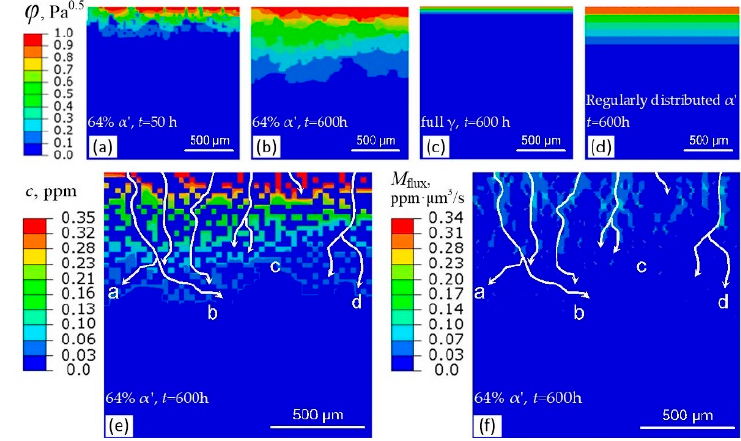
Figure 16. Contour results obtained by ABAQUS. ( a – d ) Normalized hydrogen concentration, φ ; ( e ) hydrogen concentration, c; ( f ) magnitude of the concentration flux vector of hydrogen, Mflux. The white lines with arrows in ( e , f ) represent the hydrogen diffusion path. The locations, where α′ squares connect with each other to form a path, i.e., ( a – d ), show the role of α′ as diffusion “highways”.